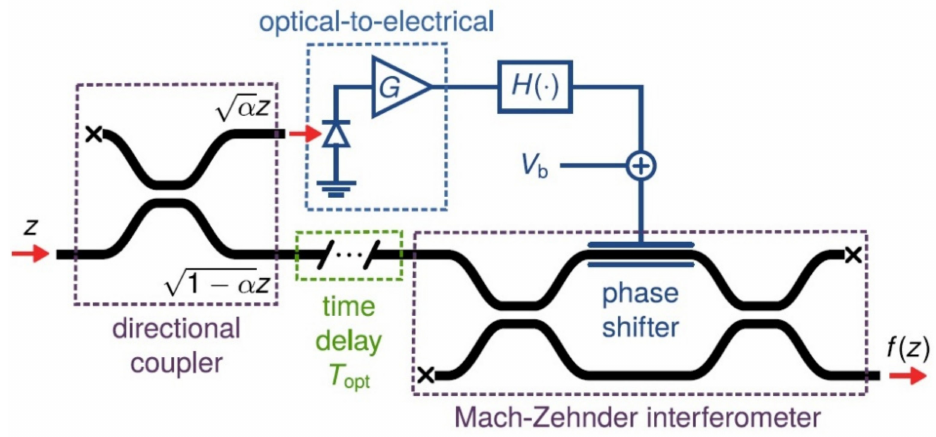
Figure 15. The arrangement for the electro-optical activation function